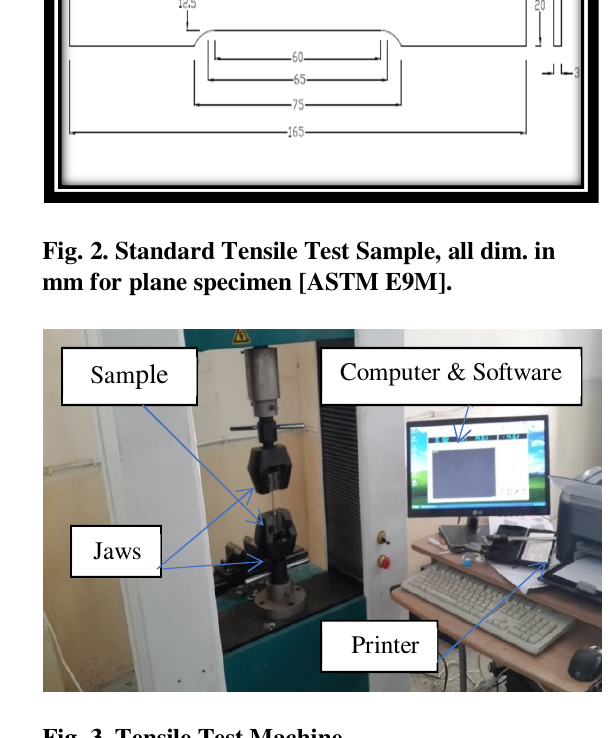
Fig. 3. Tensile Test Machine